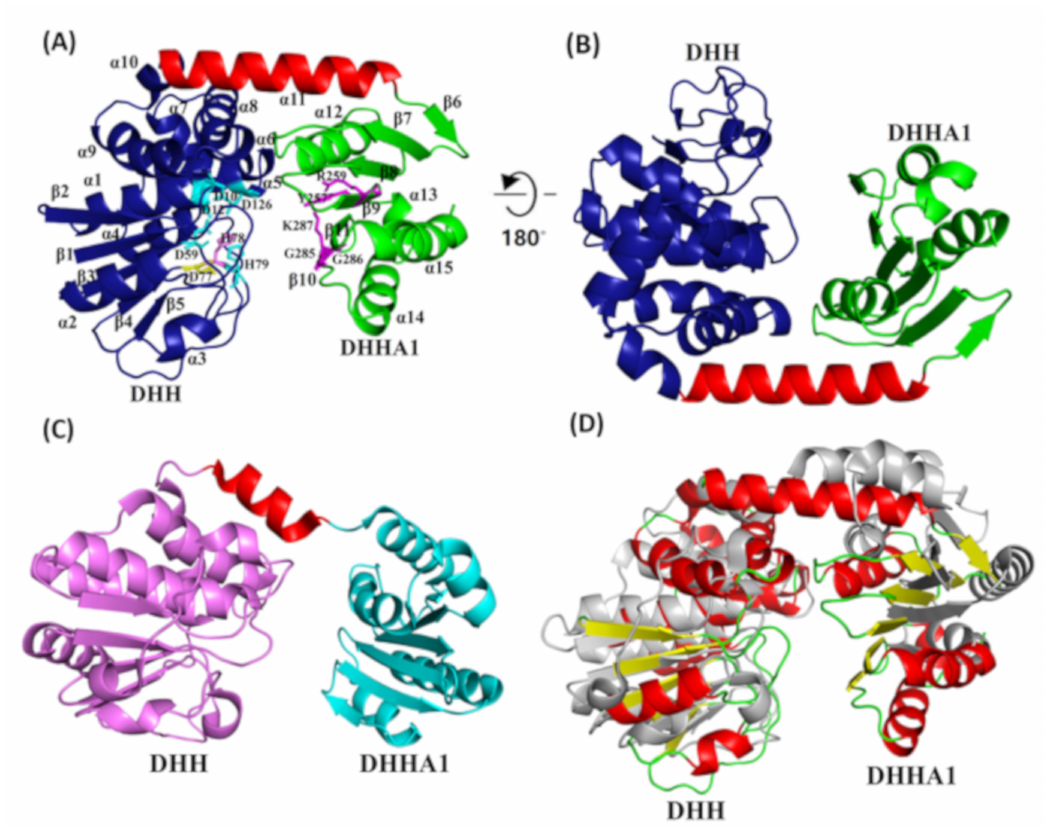
Figure 4. The overall crystal structures of archaeal PyapApase and its bacterial homologs. The overall crystal structure of archaeal PyapApase ( A ), rotation of 180 ◦ ( C ), and bacterial BsNrnA (( B ), PDB ID: 5J21) are shown as cartoon models. The DHH domain of these proteins is colored blue, α -helix linkers are red, and the DHHA1 domain is green. ( D ) The 3D superimposition of PyapApase (colored) and bacterial NrnA (gray, 5J21). The conserved key residues involved in coordinating divalent metal ions (DHH domain) and binding substrates (DHHA1 domain) are shown in ball-and-stick